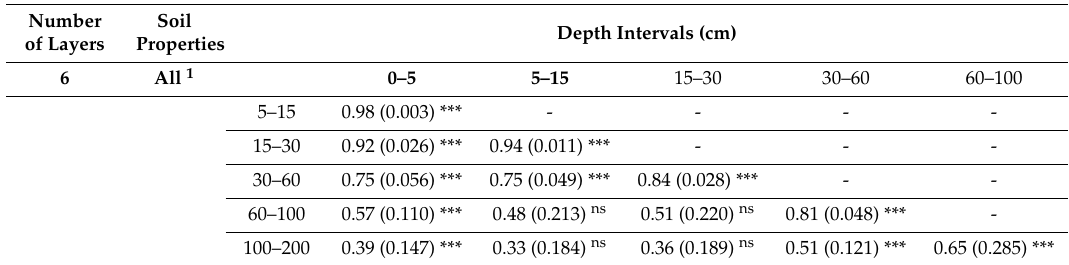
Table 8. Residuals correlation of pooled properties across